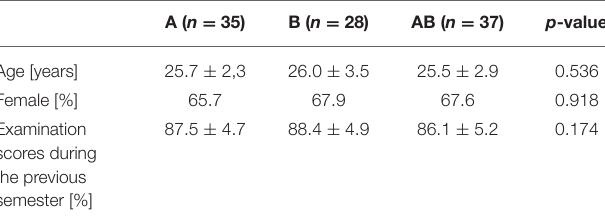
TABLE 1 | Participant